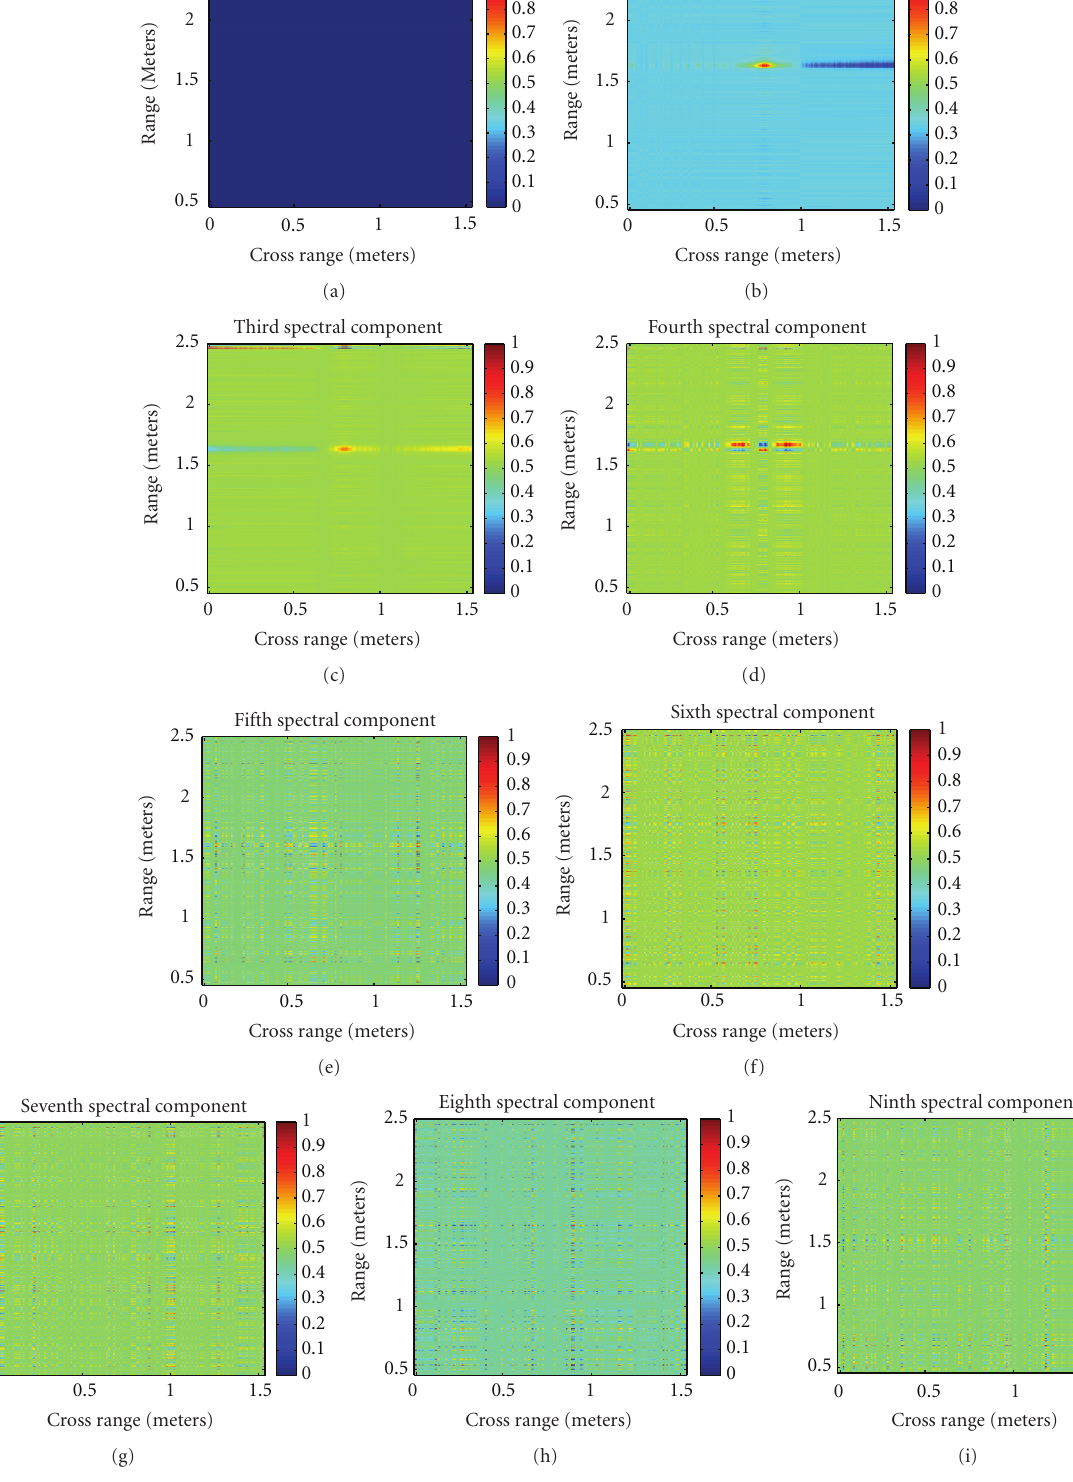
Figure 8: Example 1: Single target: di ff erent spectral